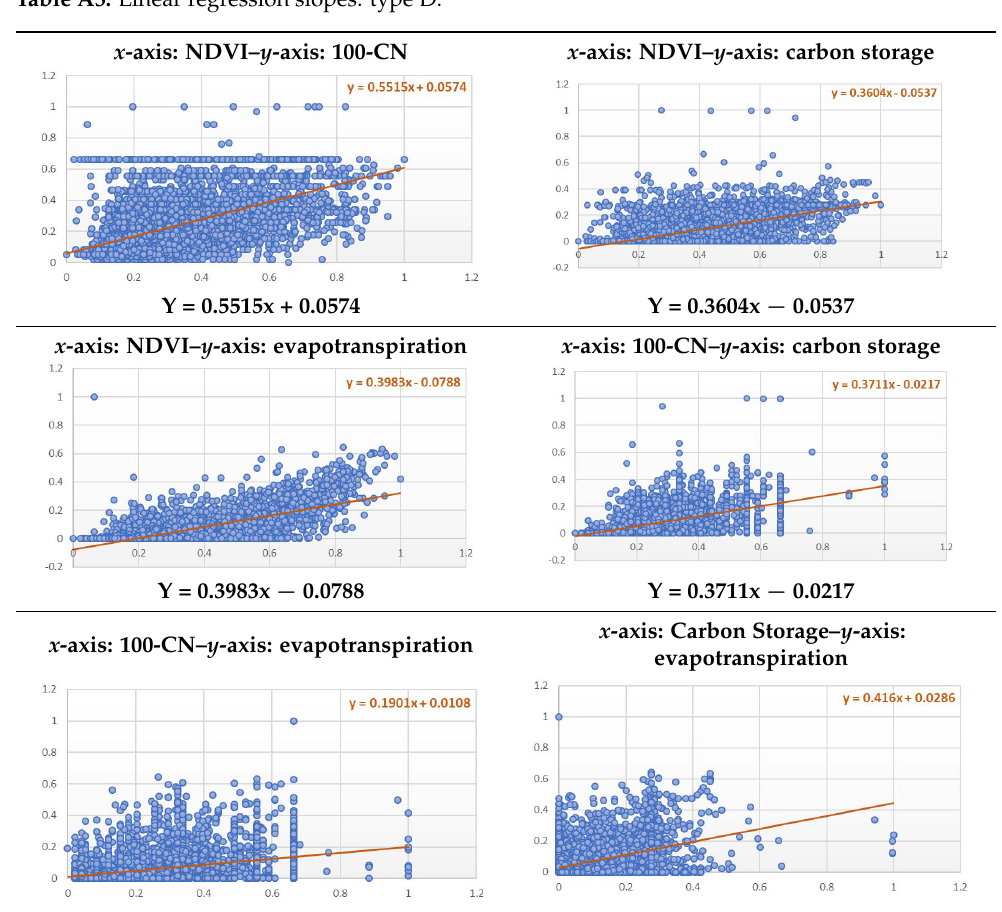
Table A5. Linear regression slopes: type